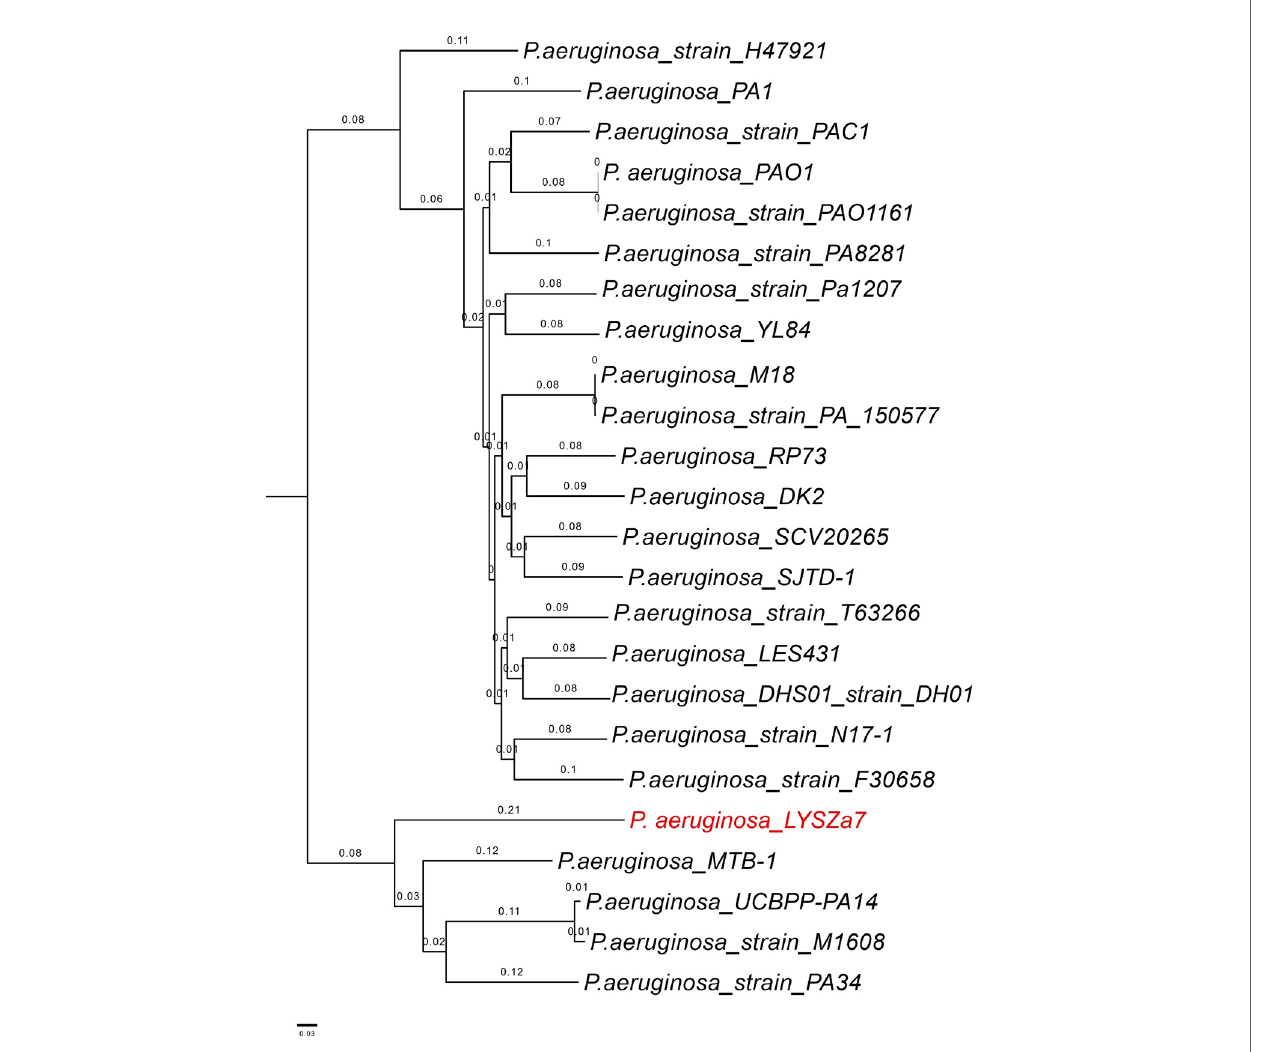
FIGURE 3 | Phylogenetic tree constructed using whole genomes of LYSZa7 and 23 other P. aeruginosa laboratory, clinical and environmental strains selected from NCBI database. P. aeruginosa PAO1 was used as reference